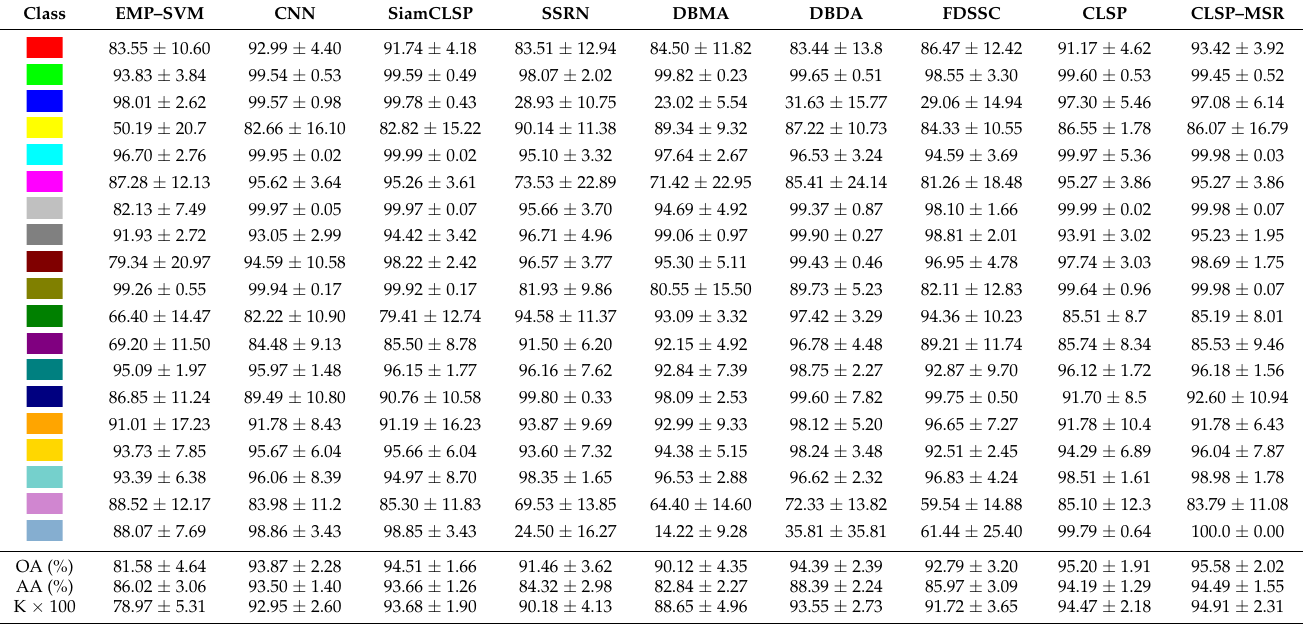
Table 9. Testing data classification results (mean ± standard deviation) on the Chikusei dataset.